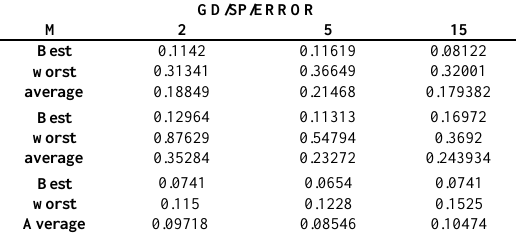
Table 5. GD/SP/ERROR analysis on first test function. GD/SP/ERROR